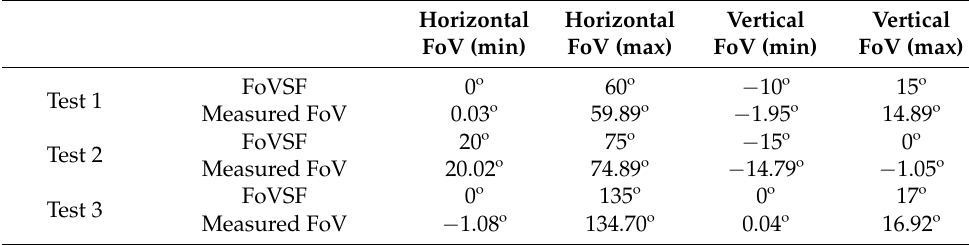
Table 3. Test results for the FoV